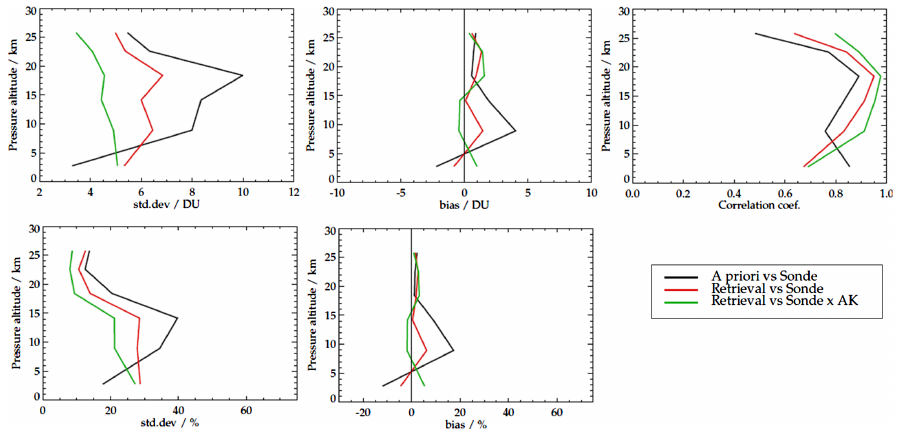
Figure 4. Statistical comparison of RAL GOME-2 ozone profiles with ozonesondes sampled worldwide for 2007–2008. Collocation criteria are given in the text. The standard deviations (left) and biases (centre) in GOME-2 minus ozonesonde values are in absolute (DU) units and as % of sonde value in the top and bottom rows, respectively. The top right panel shows the correlation coefficient. Points denote the mid-point of each subcolumn. In each case, results are shown for the a priori vs. sonde and for the retrieval vs. sonde with and without application of AKs to the ozonesonde profiles. Statistics have been derived from percentage difference calculated with respect to each individual ozonesonde.